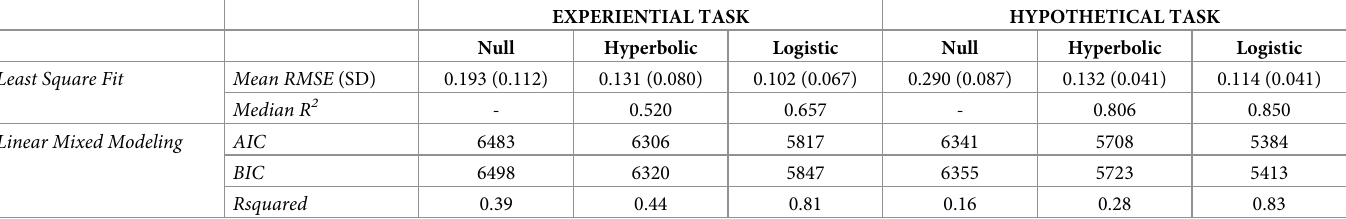
Table 1. Goodness of fit of the experiential and hypothetical indifference points, comparing fit by the hyperbolic model, logistic function model, and null model (defined as the mean of the indifference points for each